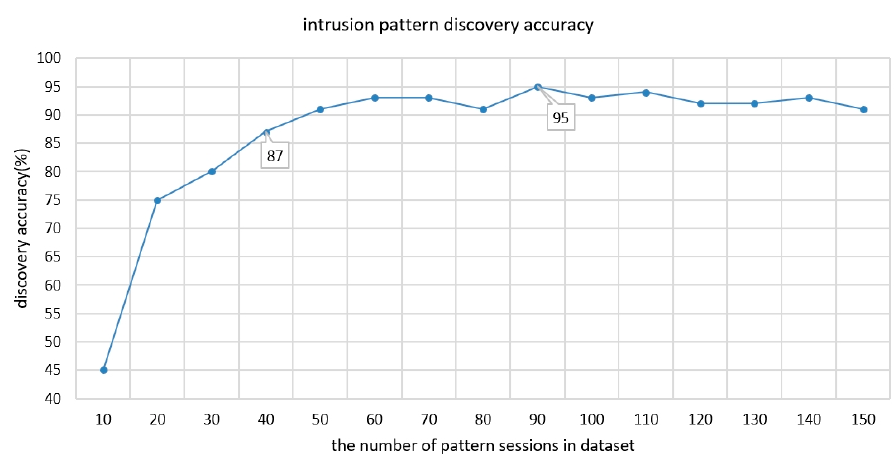
Figure 12. Intrusion pattern discovery accuracy of the proposed method.